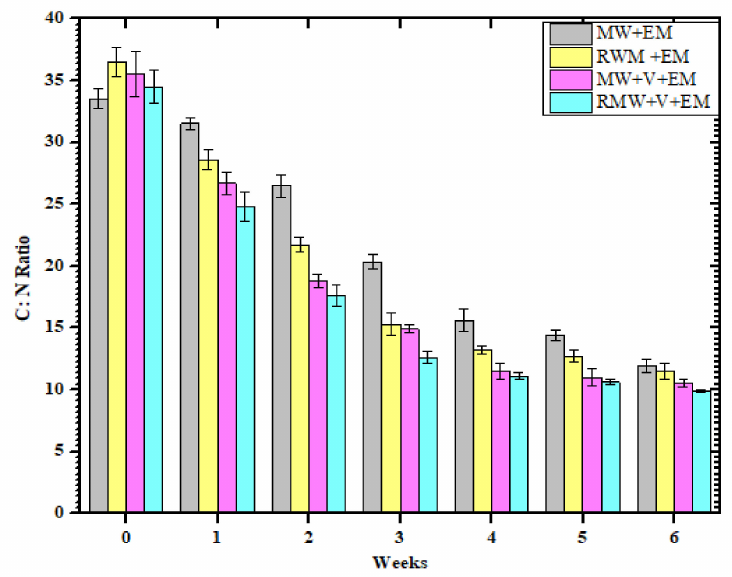
Figure 7. Variation of the C:N ratio within different weeks of [MW+EM], [RMW+EM] [MW+V+EM] and [RMW+V+EM]. Error bars represent standard errors for six